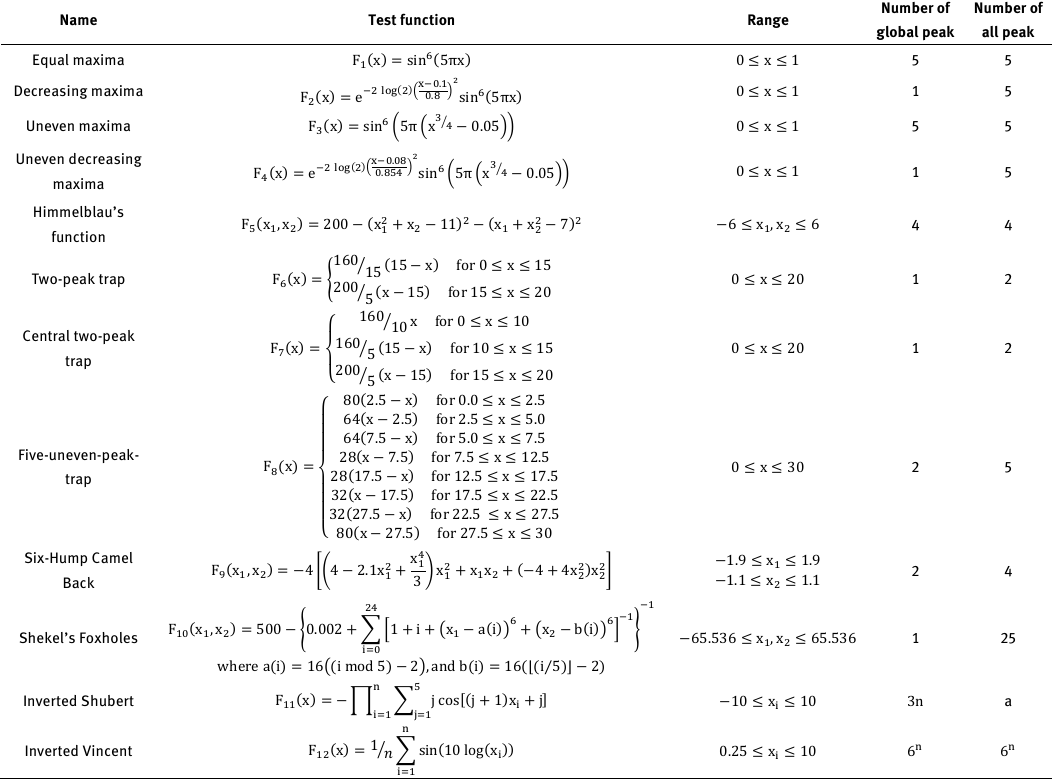
Table 1A: Unconstrained test functions in the experiments (see [15])